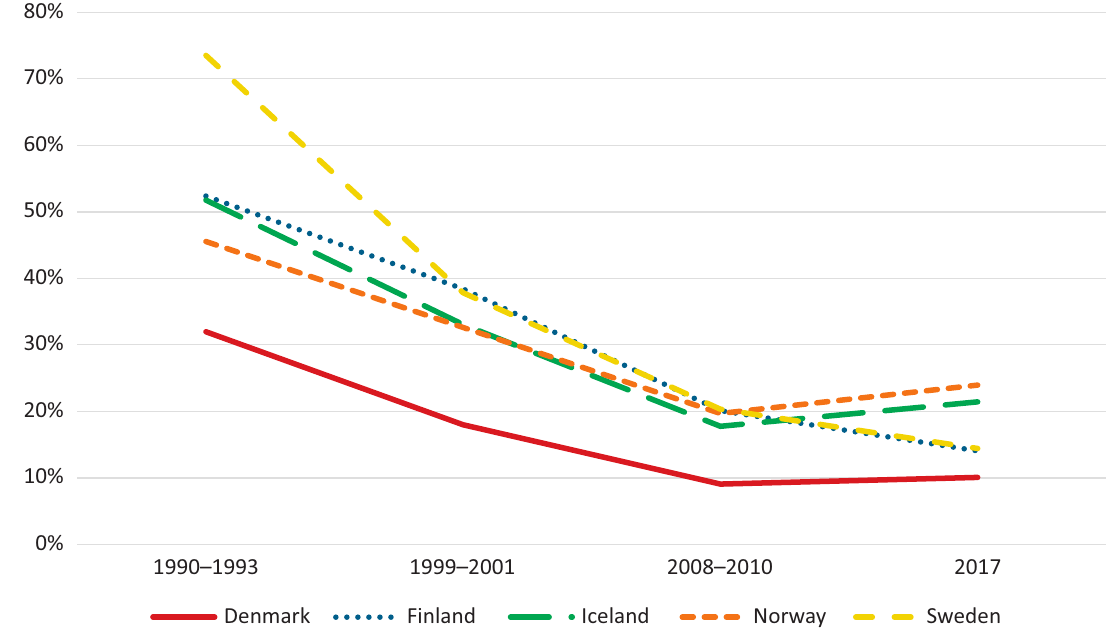
Figure 1. Percentage in sample agreeing that “when a mother works for pay, the children suffer” (all age groups,